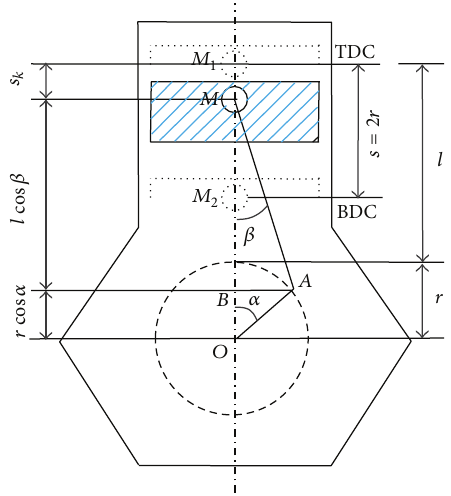
Figure 2: Kinematic relation of the crank and connecting rod